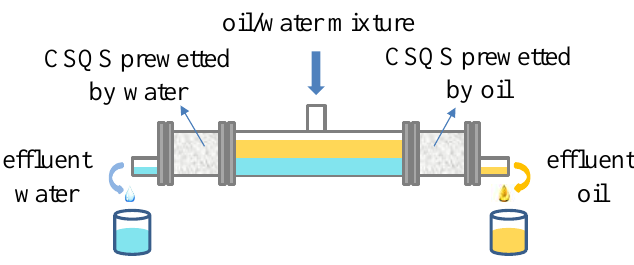
Figure 1. Diagram of the filtration experiment device.